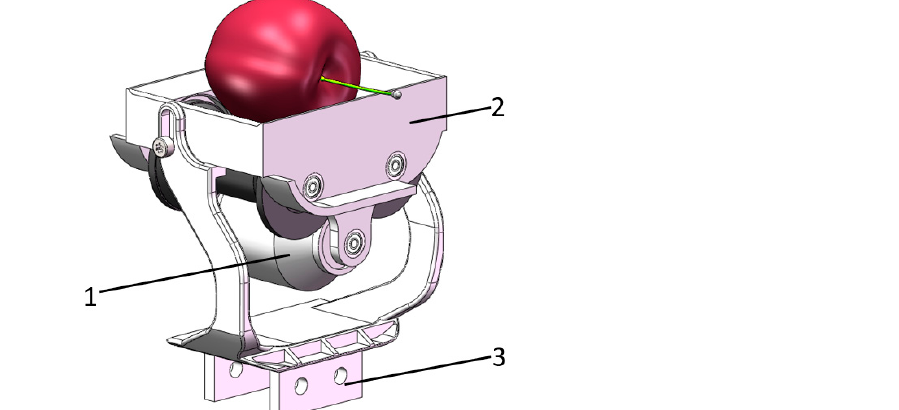
Figure 4. Functional model of the full-view-type grading cup: 1—rotating roller mechanism; 2— multi-functional frame; and 3—base plate.